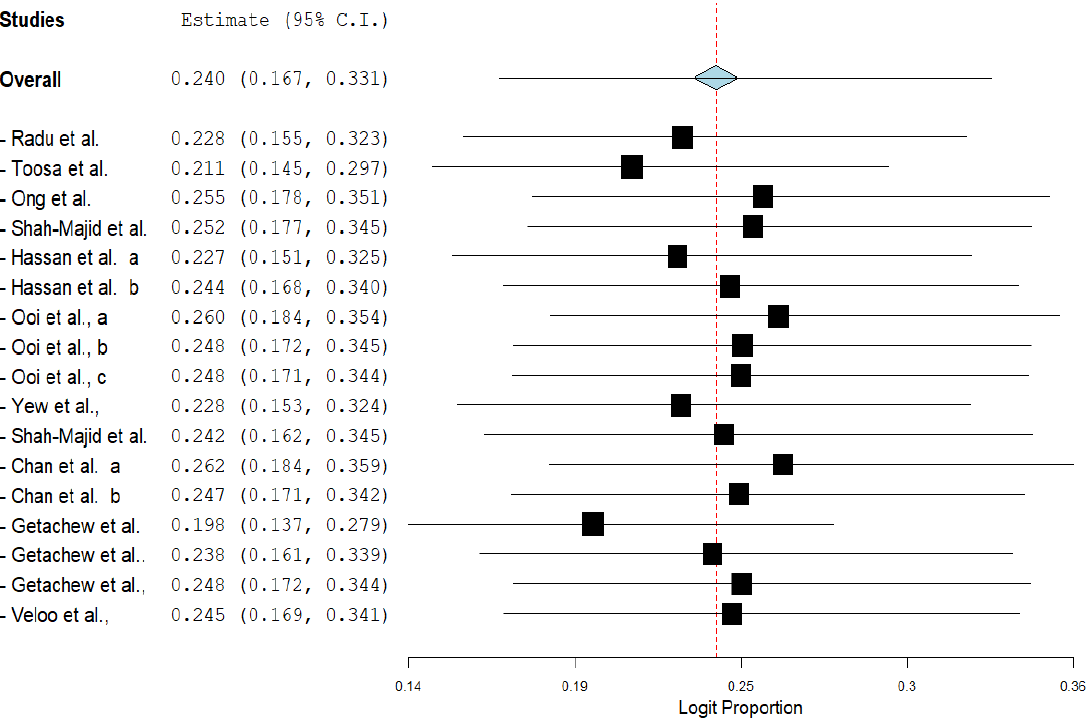
Figure 3. Leave-one-out forest plot of VRE in poultry in Malaysia.